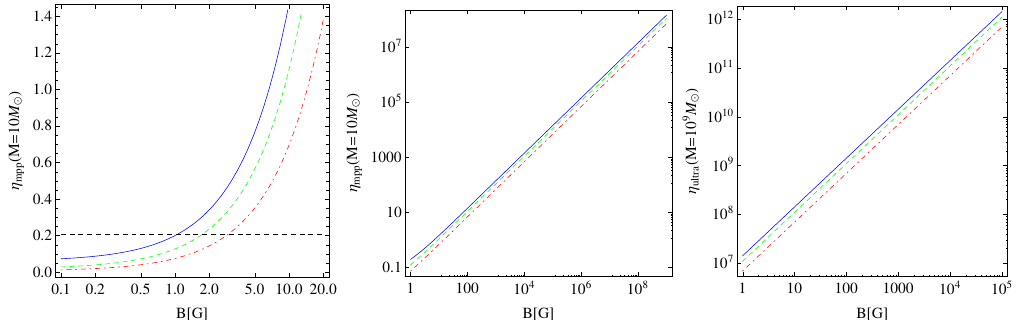
Figure 1. Efficiency of MPP in ultra-high regime: ( left , middle ) stellar mass black hole of mass 10 M (cid:12) ; and ( right ) supermassive black hole of mass 10 9 M (cid:12) . Dashed horizontal line on the left plot correspond to the efficiency of original Penrose process for black hole with extremal spin. Colored curves correspond to various spins: a = 0.8—solid blue, a = 0.5—dashed green and a = 0.3—dot-dashed